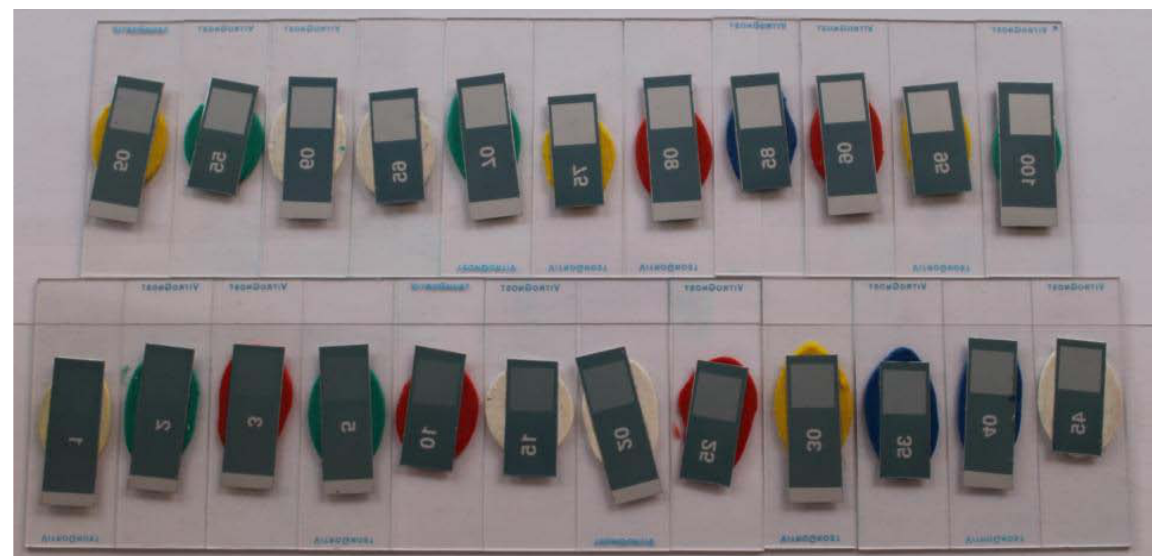
Figure 10. Printing plate